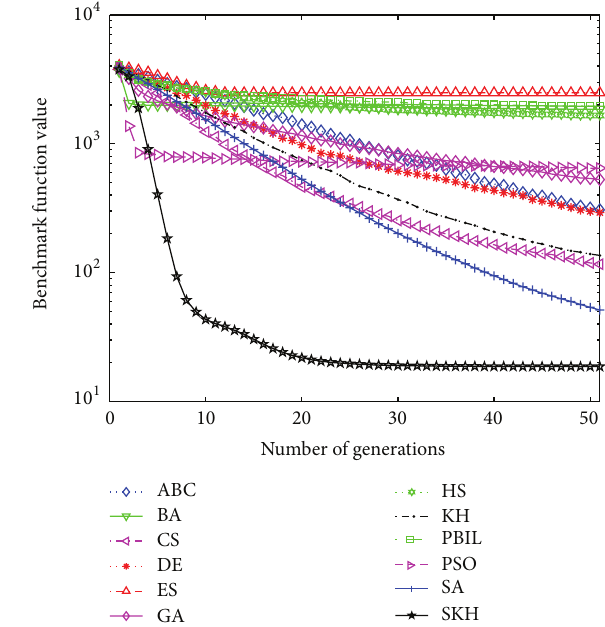
Figure 2: Comparison of the performance of the different methods for the F04.